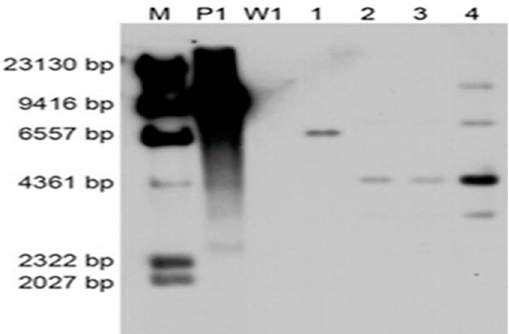
Figure 6. Southern blot analysis of transformants. The numbers (1–4) indicate different transformants using W1 as the recipient strain; M: λ - Hin d III molecular maker; P1: Plasmid pCAMBIA-1300-GFP; W1: L. edodes strain W1.